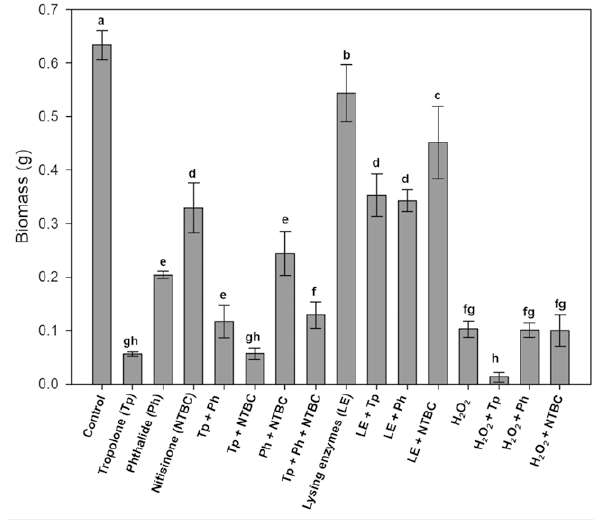
Figure 4. Mean weights of Lasiodiplodia gilanensis biomass in the presence of melanin inhibitors and under stress conditions. Bars indicate standard deviations. Means accompanied by the same let- ters are not significantly different (α <